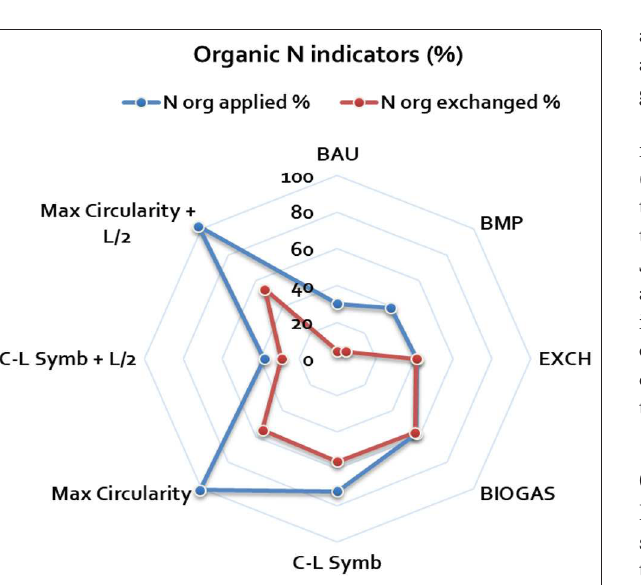
FIGURE 6 | N indicators from FAN scenario outputs, expressed as a percentage of total N. “N orgapplied % ” accounts for all organic sources of N added to soils, whereas “N orgexchanged % ,” takes into account only the part of organic N that is exchanged between two agents before being used for fertilization, see Equation 1, Equation 2. Scenarios names are in Figure 3 and Table 2